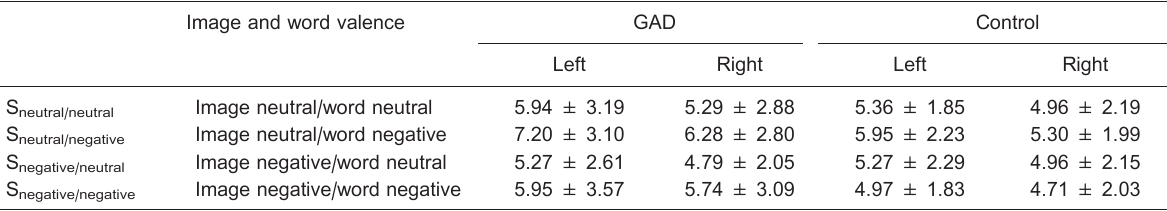
Table 2. Mean amplitudes for P200 on the left and right sides under each condition ( m v). Image and word valence